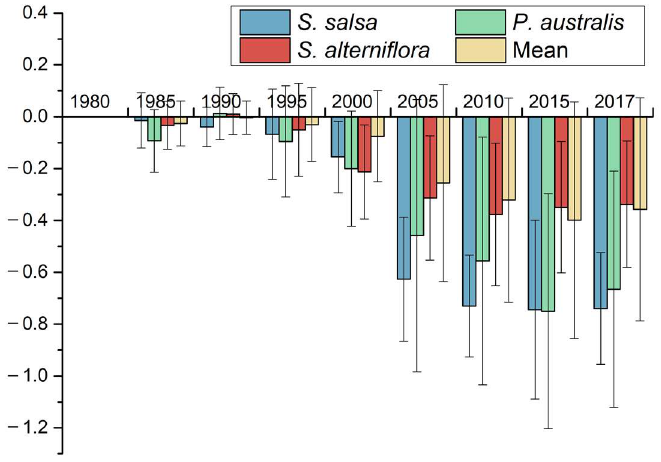
Figure 13. The change in the land–sea exchange function index of different types of vegetation in the coastal wetland of Yancheng.